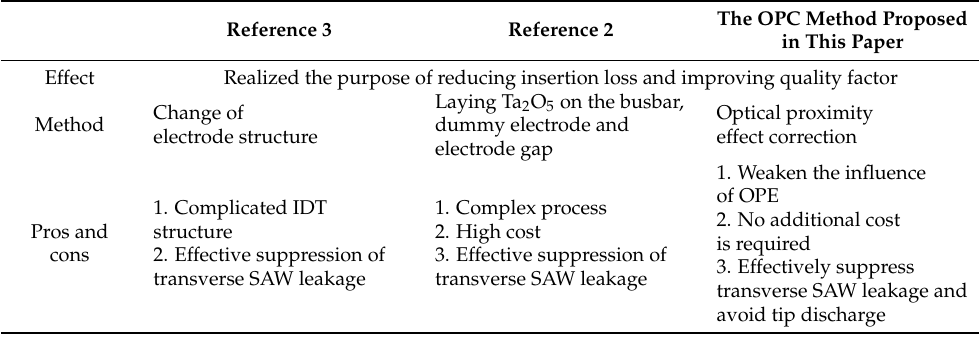
Table 3. Comparison with other